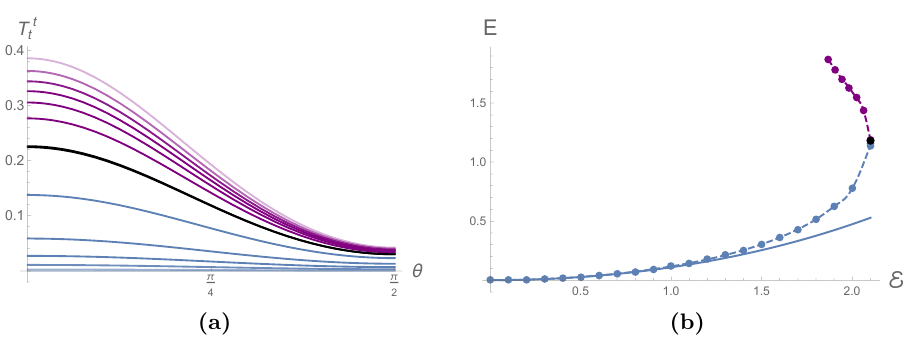
Figure 3. (a) Energy density on the AdS boundary and (b) total energy of the boundary theory as a function of the electric (cid:12)eld (setting G N = 1). The solid curve in (b) is the analytical result E found from perturbation theory around = E